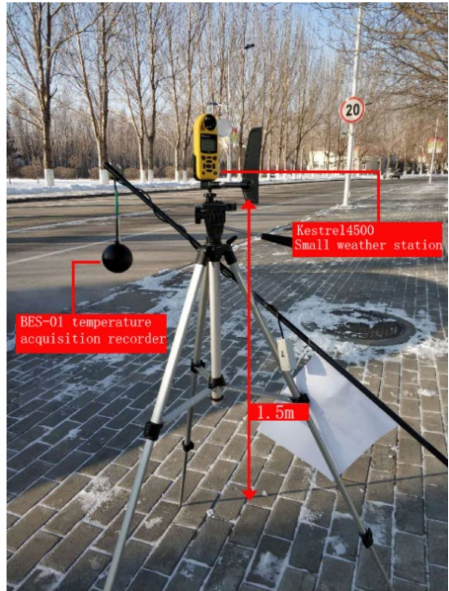
Figure 4. Weather station